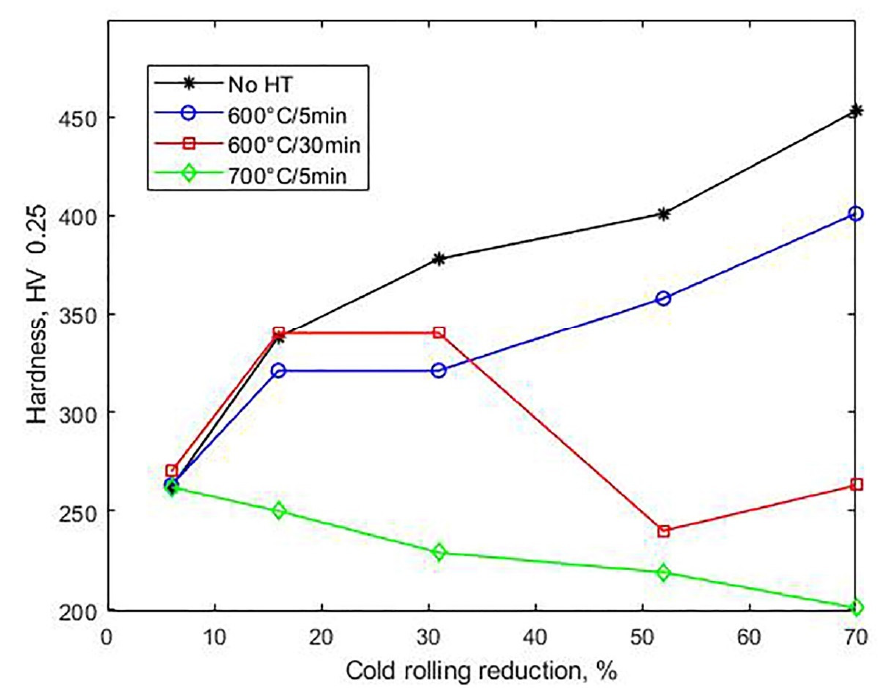
Figure 7. Effect of recrystallization annealing after cold rolling on Vickers hardness. As a reference, data for specimens without heat treatment (No HT) are also shown.